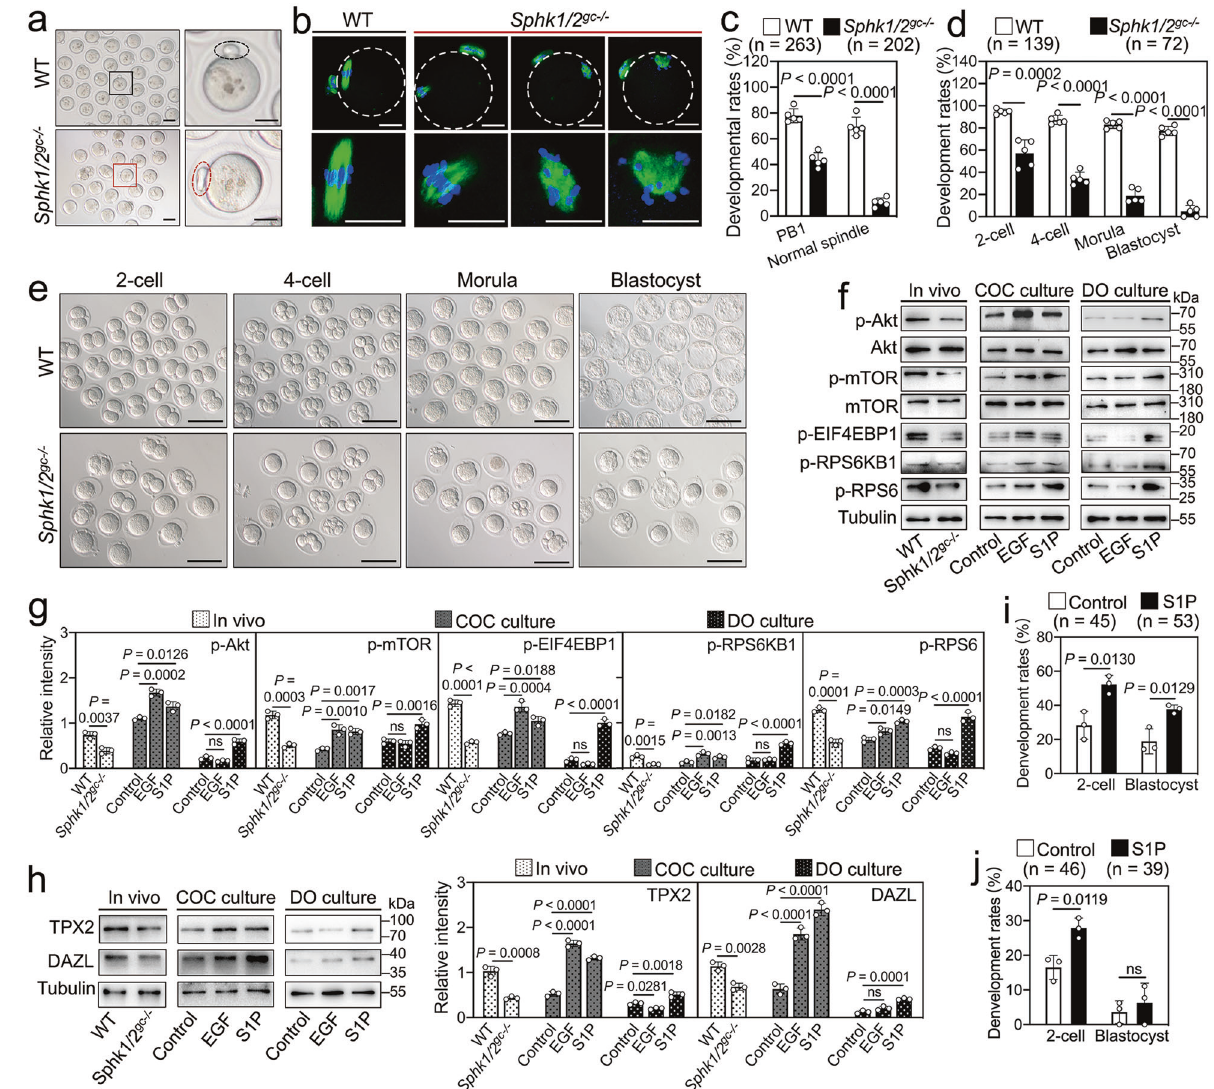
Fig. 6 Sphk1/2 depletion in granulosa cells impairs oocyte developmental competence. a Representative images of oocytes collected from the oviducts of WT and Sphk1/2 gc − / − mice at 13 h post-hCG. The enlarged views of the black and red boxed area are shown on the right side. The black dotted circle represents normal PB1, and the red dotted circle represents abnormal PB1 (large PB1). b Immuno fl uorescent staining of α -tubulin showing spindle assembly in MII oocytes ovulated by WT and Sphk1/2 gc − / − mice. The enlarged views indicate the morphology of microtubules (green) and chromosomes (blue). Representative images are shown. c Quanti fi cation of the rates of PB1 emission and normal spindle formation in oocytes ovulated by WT and Sphk1/2 gc − / − mice. The numbers of analyzed oocytes are indicated ( n ). d , e Developmental rates ( d ) and representative images ( e ) of preimplantation embryos from WT and Sphk1/2 gc − / − mice. The numbers of analyzed embryos are indicated ( n ). f , g Western blotting analysis of the levels of p-Akt, p-mTOR, and mTOR downstream effectors p-EIF4EBP1, p-RPS6KB1, and p-RPS6 in oocytes from different treatments. Oocytes were collected from the ovaries at 3 h post-hCG, the COCs at 2.5 h of culture, and the DOs at 1.5 h of culture. Total Akt and mTOR were used as the corresponding internal controls for p-Akt and p-mTOR, and tubulin was used as an internal control for p-RPS6KB1, p-RPS6, and p-EIF4EBP1. h Western blotting analysis of the levels of TPX2 and DAZL in MII oocytes from different treatments. MII oocytes were collected from the ovaries at 13 h post-hCG, the COCs at 16 h of culture, and the DOs at 16 h of culture. For the S1P treatment group, COCs or DOs isolated from eCG-primed mice were cultured in a medium with S1P for 0.5 h and then cultured in an S1P-free medium for an additional 15.5 h. Tubulin was used as an internal control. i , j Quanti fi cation of the rates of two-cell stage embryos and blastocyst stage embryos in WT ( i ) and Sphk1/2 gc − / − ( j ) mice. COCs collected from eCG-primed mice were matured in vitro with or without S1P, and then were fertilized in vitro. The numbers of analyzed embryos are indicated ( n ). The data represent the mean ± s.d. P values were determined by two-sided Student ’ s t -test ( c , d , g – j ) and one-way ANOVA followed by Tukey ’ s test ( g , h ). ns not signi fi 8 months. The number of pups per litter was recorded at birth, and the according to the manufacturer ’ s instructions. Reverse transcription was average cumulative number of pups per female was calculated at the end of performed directly after RNA isolation using the QuantiTek reverse the fertility test. Switzerland). Target gene expression was calculated based on the 2 − ΔΔ Ct method using ribosomal protein L19 ( Rpl19 ) and/or glyceraldehyde-3- phosphate dehydrogenase ( Gapdh ) as the endogenous control. For RNA- using the RNeasy micro-RNA isolation kit (Qiagen, Valencia, CA, USA)